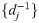
ASE improves forecasting of fluctuations in simulated near-neutral dynamics.A, Schematics showing ASE and S-map algorithms. Bottom: in standard S-map algorithm, ‘fitting’ is performed by embedding available historical data into a time-lagged state space. Predictions from a time point (Xt) are then made by identifying nearest neighbors in the embedded space and performing a linear regression weighted by their inverse distance ({dj−1}) from the current point to estimate local dynamics. The neighbors are inevitably far from the current point for unprecedented fluctuations. This estimate (θ) is then used to predict future abundance (St). Top: ASE supplements the data in unsampled regimes. Avalanche events are segmented from historical data and used to fit the size-duration scaling S = bTγ (red line), where γ = 3/2 is set constant across communities. The unit duration (b) is used to generate ASE data (orange) using the scaling relationship and average avalanche trajectory (Eq 2). The ASE data are fed into S-map algorithm and integrated with the raw data for forecasting. B, Relative prediction error (RE) on dynamics with various degree of marginal stability using S-map with ASE only (orange), S-map with raw data (purple), and AR1 with raw data (cyan). For each condition 1,000 training sets were segmented randomly from a simulation (length = 108) of Eq 1 and used to predict 3,000 time points in a separate simulation. Training sets have a fixed length of 1,000 time steps. C, Relative prediction error vs. training data length. For each length, 500 training datasets were segmented randomly from a simulation (length = 108) of Eq 1 (λ = 10−5). Each training dataset was used to predict 1,000 time points in a separate simulation. D, Relative error vs. training data average magnitude. The training sets have a fixed length of 100 time steps. The predictions were made on the largest 5% of values in the simulated testing data (λ = 10−5). Dashed line: the median magnitude of training datasets, showing >50% of training data fall within the first bin. Symbol size scales with the number of data points in each bin. To accumulate statistics, 5,000 training sets were segmented and used to predict 5,000 points in a separately simulated dataset. In B-D, embedding dimension: m = 10, prediction time: P = 50. Symbols: median; error bars: interquartile values.